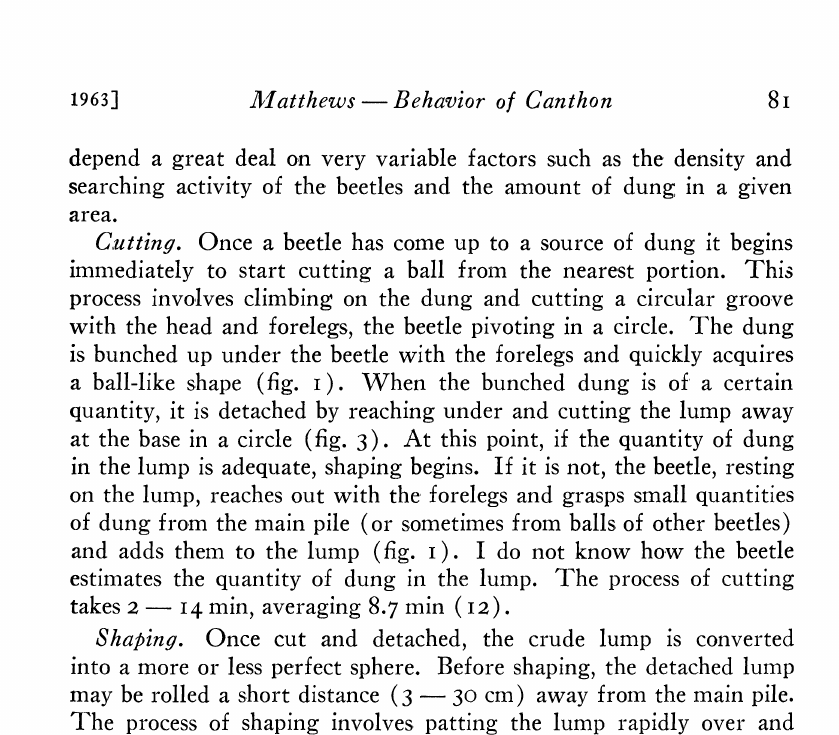
Fig. 1. Lone beetle adding more material to food ball during cutting process. Fig. 2. Lone beetle shaping food ball. Forelegs are used to pat surface of ball. Fig. 3. Male and female pair cutting brood ball. Beetle at right is severing ball at base. Fig. 4. Male and female pair shaping brood ball. Both beetles are going over surface of ball with forelegs. Fig. 5. Rolling completed brood ball. Male is below, pushing ball backwards over an obstacle. Female is above, balancing on moving ball. This relationship of the sexes during rolling is invariable. Note smooth contours of completed brood